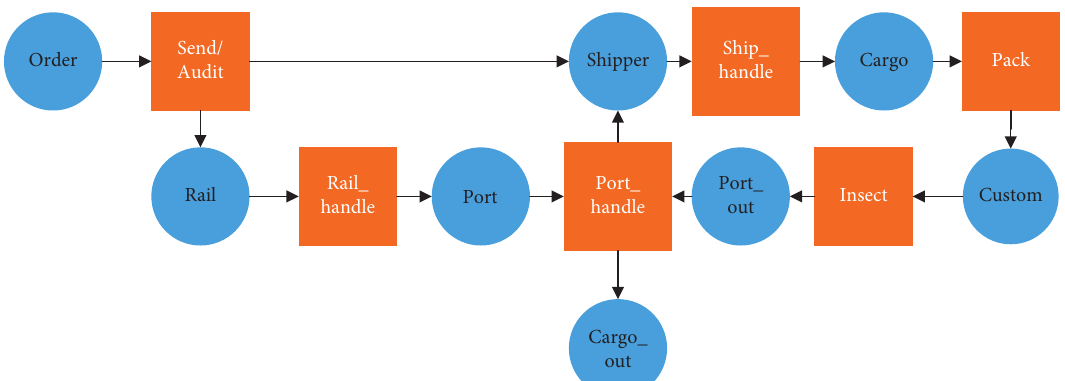
Figure 8: Process simulation screenshot before reconstruction.